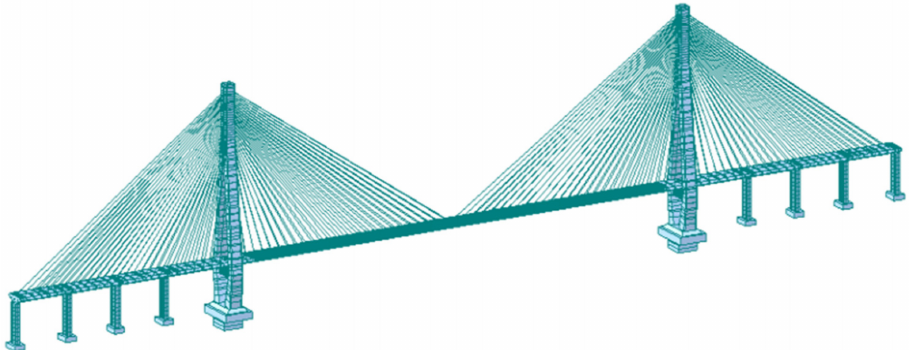
Figure 8. The initial FE model of the Yongjiang Bridge.